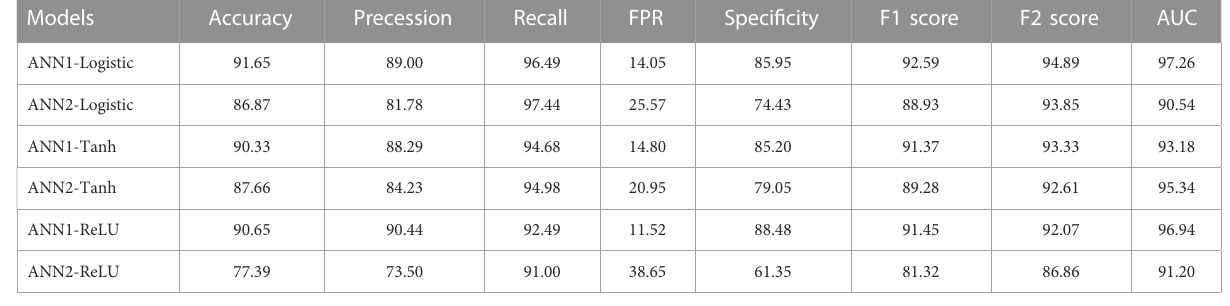
TABLE 3 Performance evaluation of developed six ANN models on plant dataset based on accuracy, precession, recall, FPR, speci fi city, F1 score, F2 score and AUC ( fi gures in percentage). Models